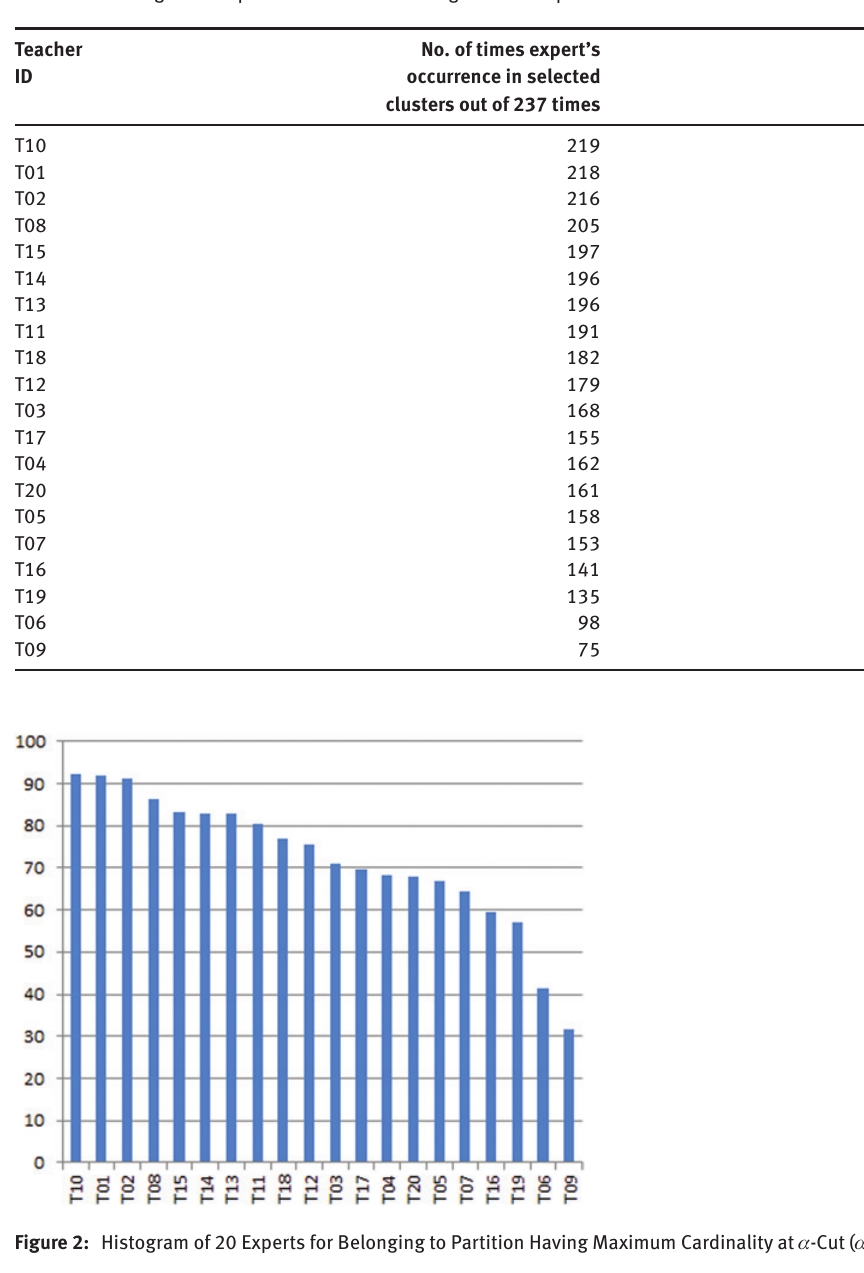
Table 9: Ranking of 20 Expert’s at α -Cut 0.98 Using Cosine-Amplitude Method for 237 Students.